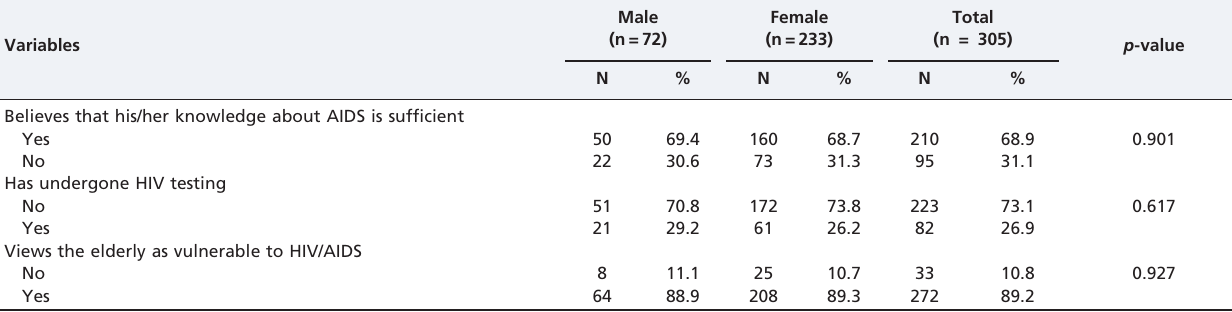
Table 2 - Knowledge about HIV/AIDS, previous HIV testing, and perceived vulnerability in elderly individuals attending community centers in Campo Grande, MS, Brazil, 2009.